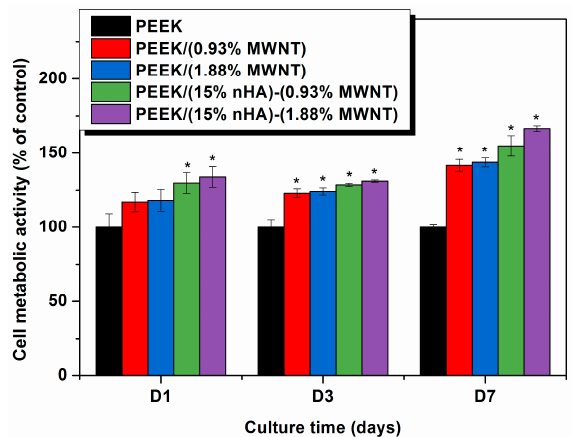
Figure 12. 3-(4,5-Dimethylthiazol-2-yl)-2,5-diphenyltetrazolium bromide (MTT) assay results showing cell metabolic activity of murine MC3T3-E1 pre-osteoblasts grown on PEEK and its nanocomposites for 1, 3 and 7 days. * represents p < 0.05. Significance is assessed for each time-point assayed.